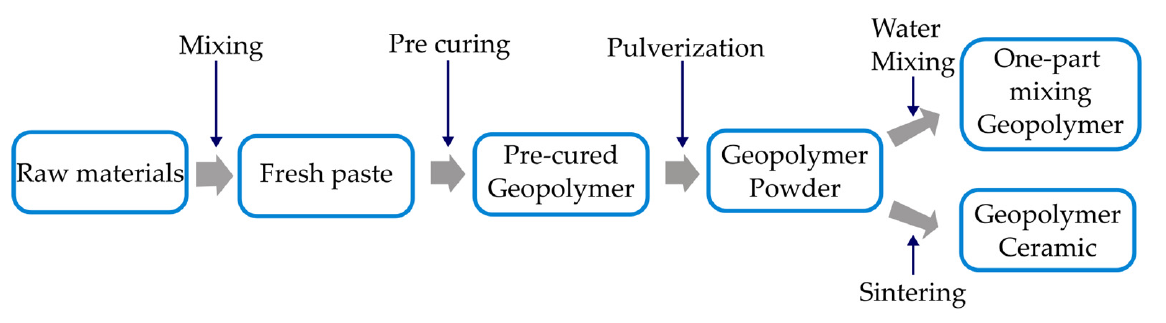
Figure 3. Steps to produce geopolymer powder, one-part-mixing geopolymer and ceramic geopolymer [48].